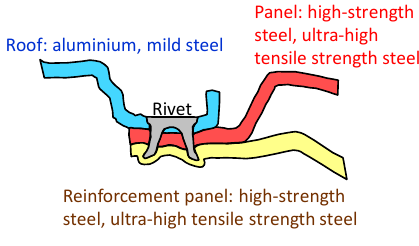
Figure 1. Self-pierce riveting of three sheets in automobile body parts.